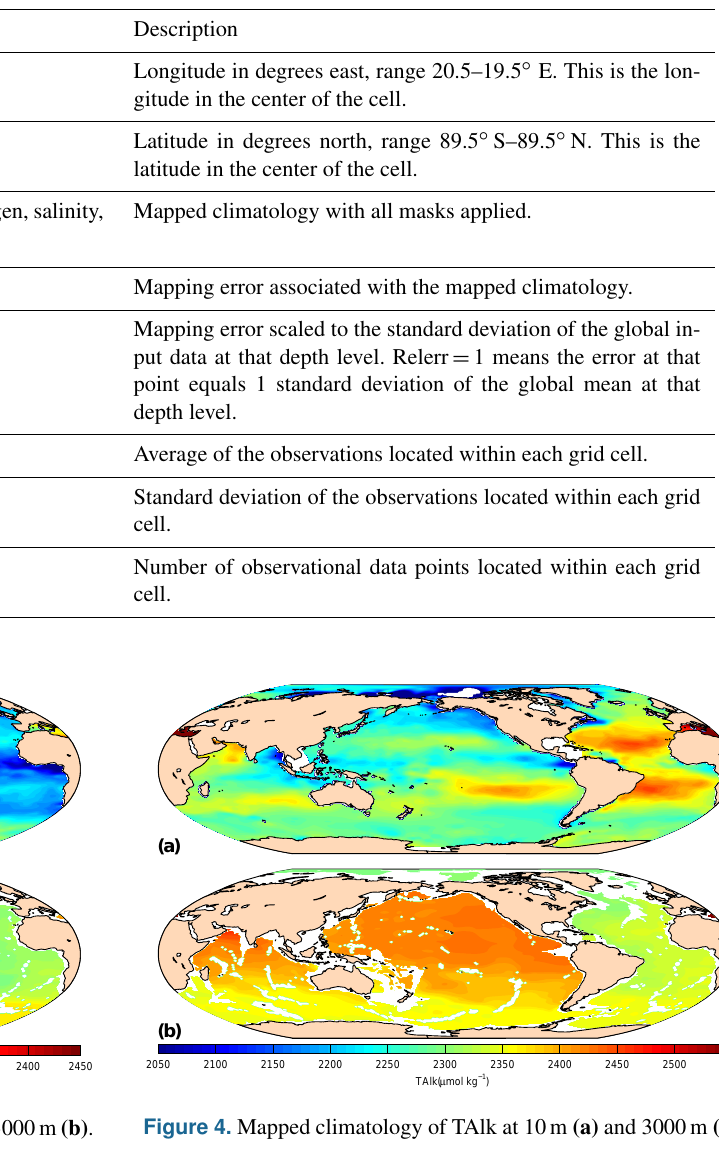
ping error at a grid point over the standard deviation of all the data on that depth level) exceeds 0.75 have been